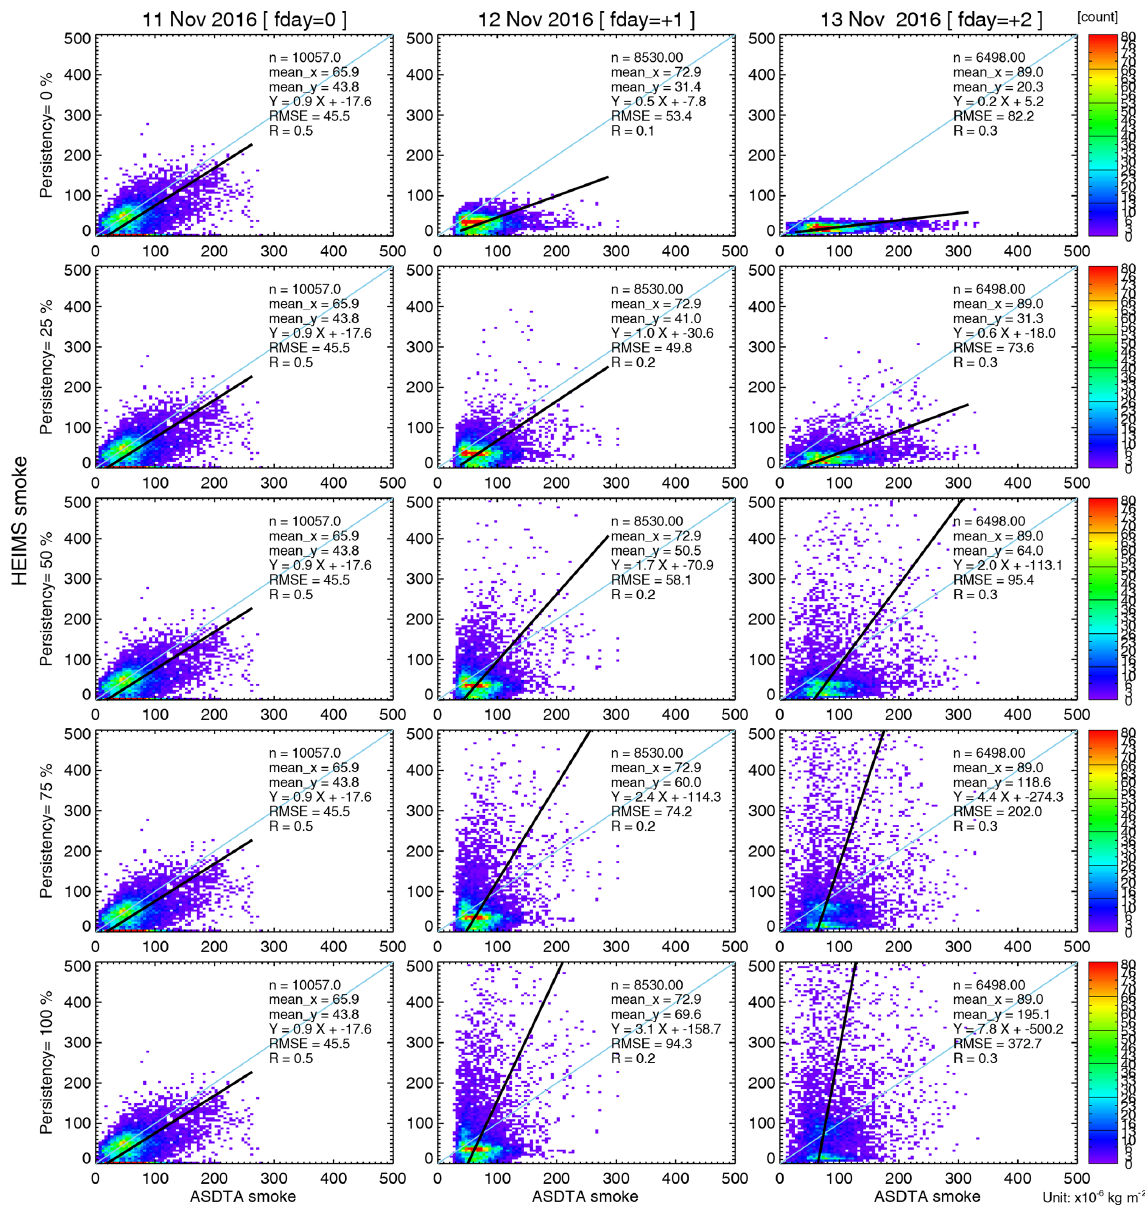
Figure 9. Sensitivity test with varying persistent rates. For p = 75%, we assume that 75% of fday = 0 emissions remain in fday =+ 1 and 56.25% (0.75 2 ) emissions remain in fday =+